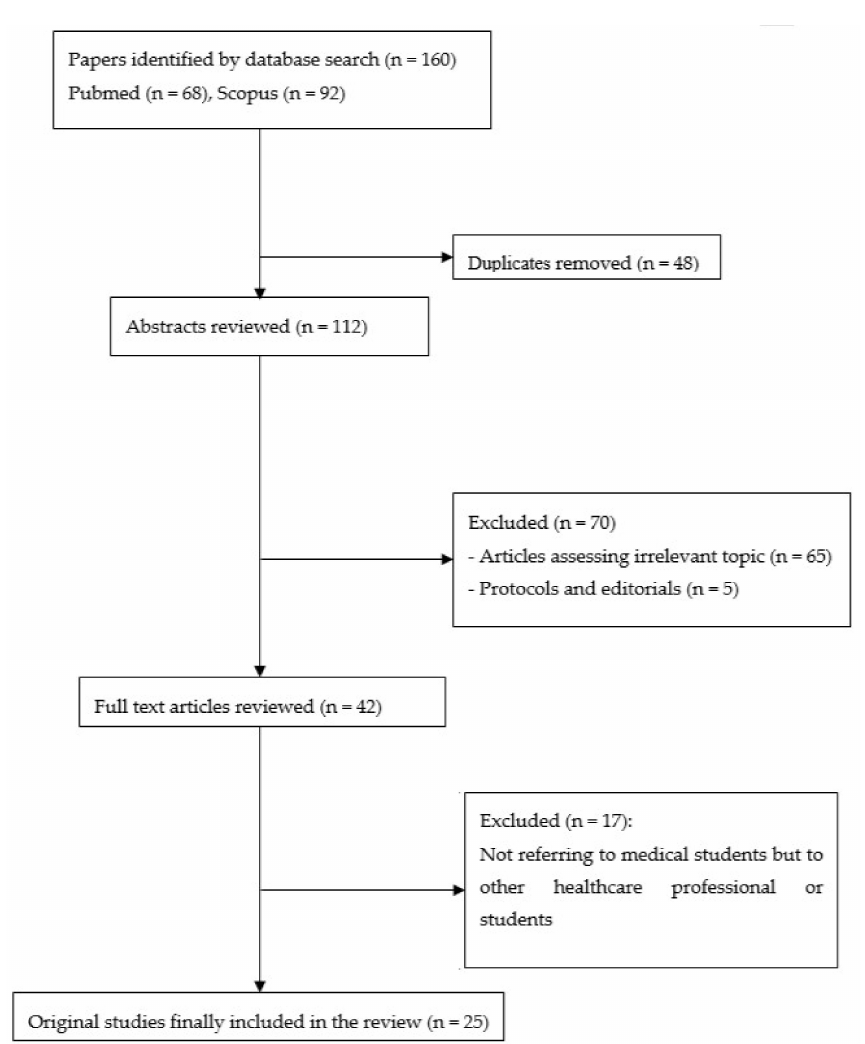
Figure 1. Flowchart of methodology and included